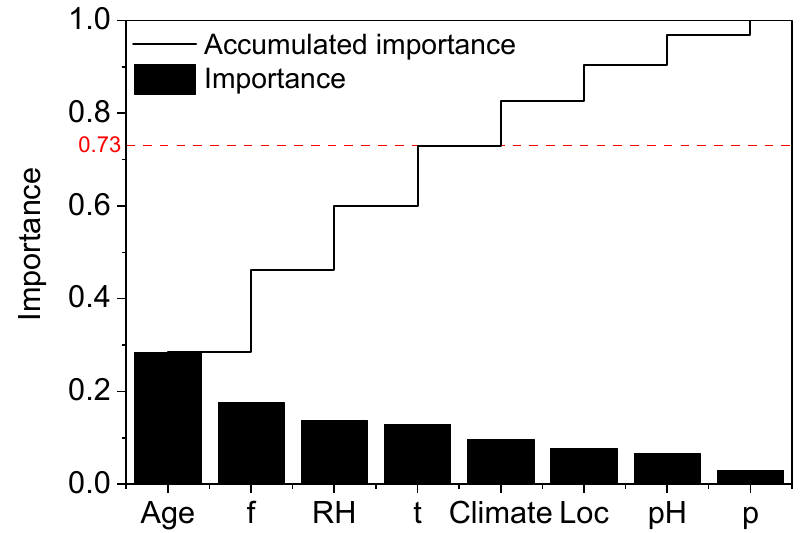
Figure 2. Importance of each parameter.